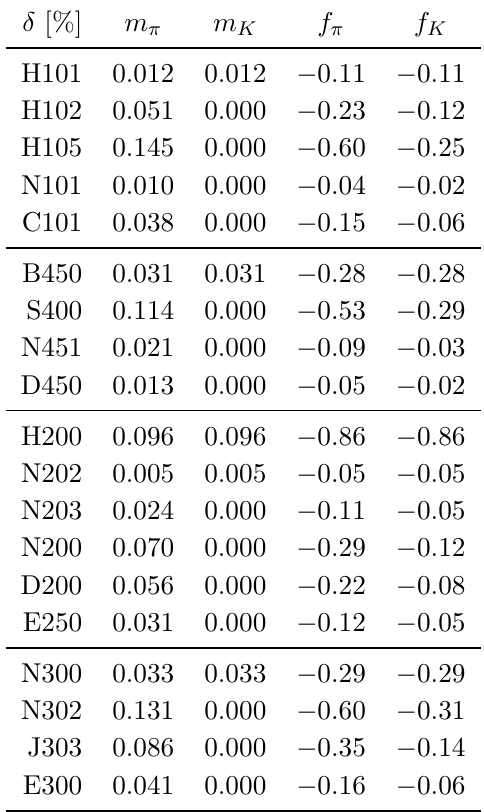
Table 9 . Finite-size effects on mesonic